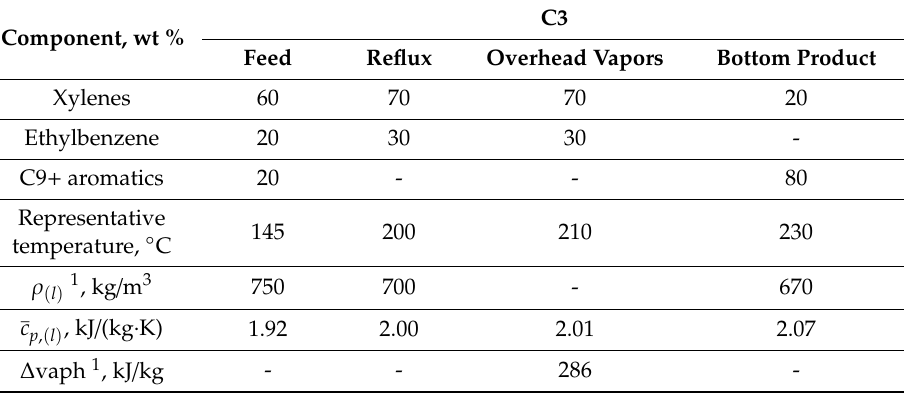
Table 4. Representative composition and physical properties approximation for C3 process streams. C9 + aromatics are represented by propylbenzene.